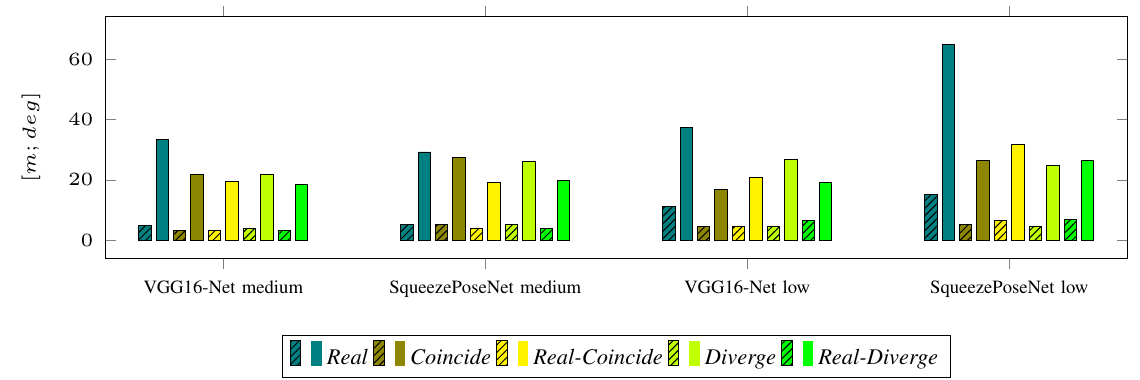
Figure 5. Visualization of mean evaluation errors. The Figure depicts the position (striped bars) and rotational (untextured bars) evaluation errors separated by the medium and low coverage sequence evaluated on the modified VGG16-Net and SqueezePoseNet. The experiments were carried out on the different training data sets Real , Coincide , Real-Coincide , Diverge and Real-Diverge . The striped bars show the mean position error (meter), the untextured bars show the mean rotational error (degree).